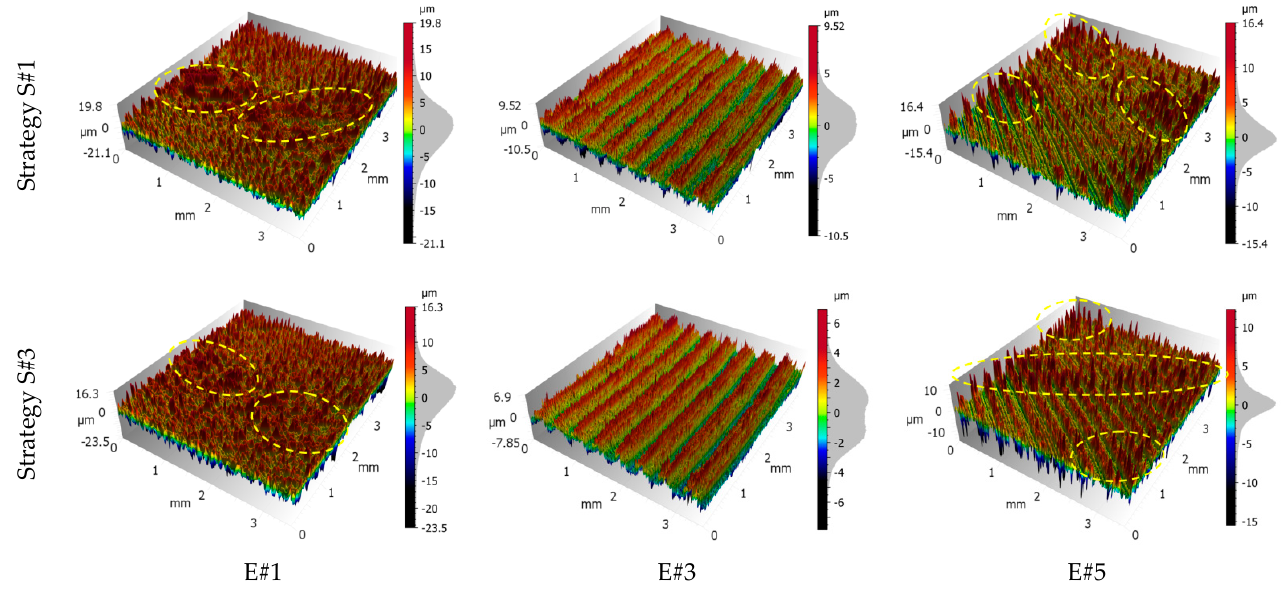
Figure 8. Surface texture views for a 6-mm-thick sample and S#1 and S#3 milling strategies. E#1, E#3 and E#5 are names of measurement areas. The ellipses drawn with a dashed yellow line indicate much higher, unevenly distributed peaks than the general structure.